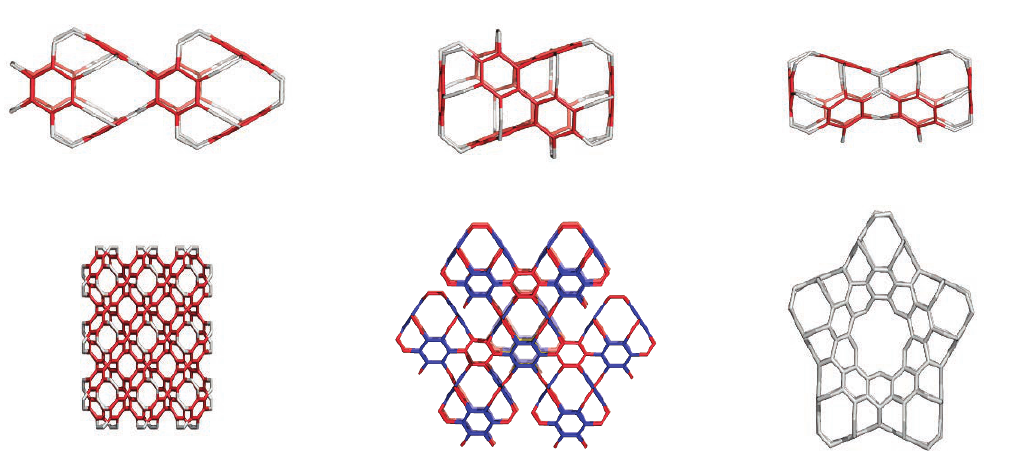
Figure 1. Top row: dimer-diamond-like BDia2_88 (left), dimer-dendrimer BDen2_84 (middle), dimer-multitorus BTA2_90 (right). Bottom row: Diamond-like net BDia_fcc(3,3,3)_864 (left), Dendrimer BDen17_ 624 (middle), Multitorus BTACy5_210, (right); the last numbers represent the atoms in